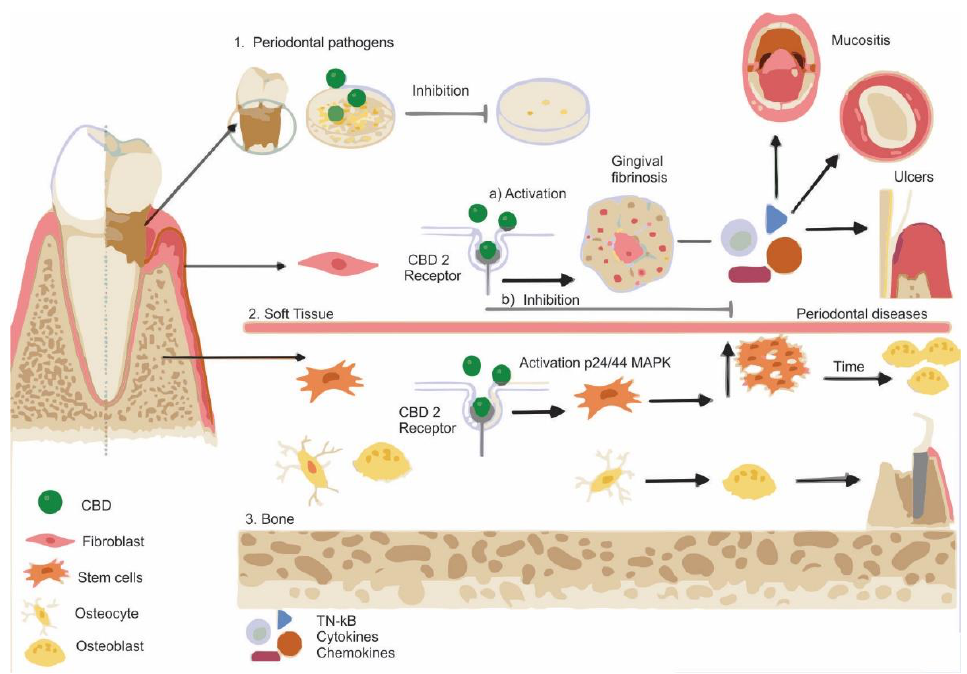
Figure 2. Applications of CBD in dentistry according to the reviewed literature. (1) CBD could reduce colonies of periodontal pathogens, showing antimicrobial properties. (2) In soft tissues, CBD could activate CB2 receptors in fibroblasts and lead to gingival fibrosis by increasing the production of gingival fibroblasts via stimulation of growth factors and decrease in matrix metalloproteinases. Simultaneously, CBD could inhibit or modulate the production of cytokines, chemokines, and pro-inflammatory growth factors, interfering with the migration of macrophages and neutrophils, generating anti-inflammatory, antioxidant, and analgesic potentials. Potential treatments include ulcers, mucositis, and as an adjunct in periodontal diseases. (3) In bone, CBD may promote the stimulation of mesenchymal cells via p42/44 mitogen-activated protein kinases (MAPK) toward the lesion site and its differentiation into osteoblasts.